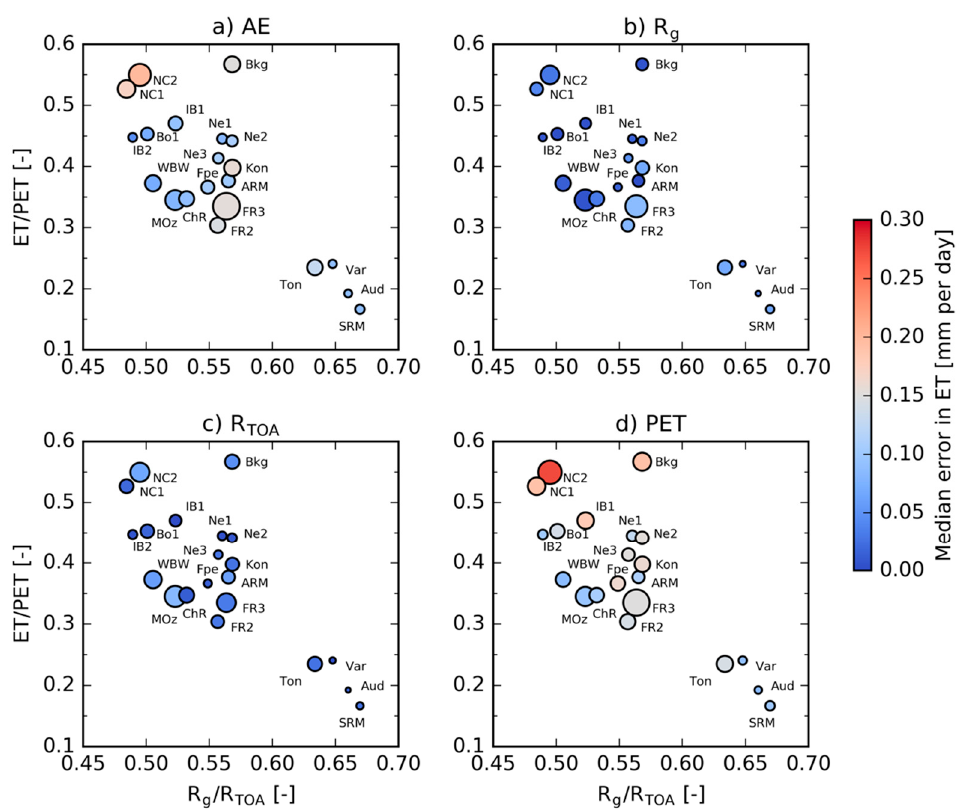
Figure 5. Median error (ME, represented by the colors) and median absolute deviation (MAD, represented by the area of the circles) between simulated and measured daytime average ET for each site depending on the ratio between the annual mean surface solar radiation (R G ) and simulated TOA radiation (R TOA ) and the ratio between the annual mean actual (ET) and potential (PET) evapotranspiration for different reference scaling fluxes: ( a ) AE, ( b ) R G , ( c ) R TOA and ( d ) PET. Scaling to daytime values was based on ET measurements at 13:00 assuming self-preservation between ET and different scaling fluxes. The MAD varies from 0.06 mm day − 1 (smallest circle) to 0.33 mm day − 1 (largest circle). The AmeriFlux site ID labels are defined in Table 2.